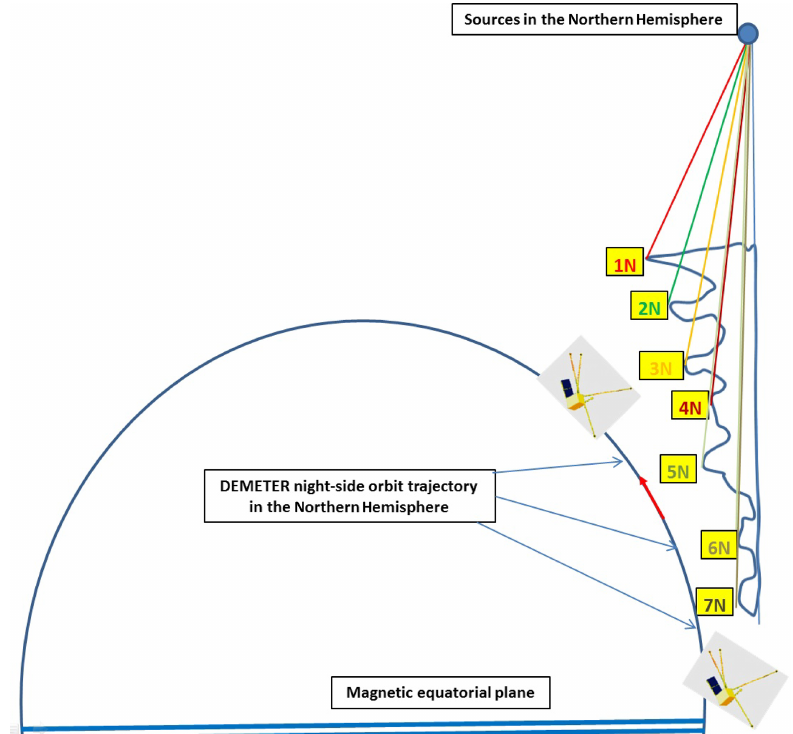
Figure 8. Sketch of the beams observed in the Northern Hemisphere for specific magnetic latitudes and frequencies (i.e. 1N, 2N, 3N, 4N, 5N, 6N and 7N) as listed in Table 1.